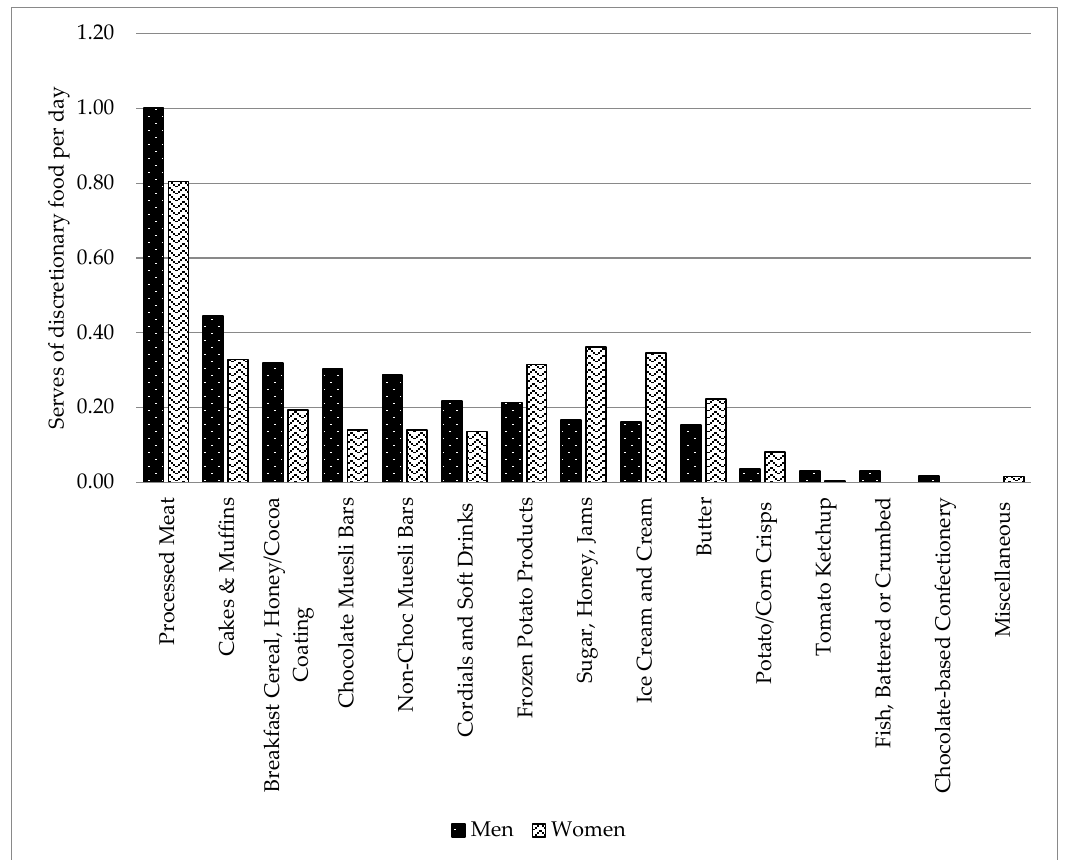
Figure 2. Serves of discretionary food items among men and women with ID.